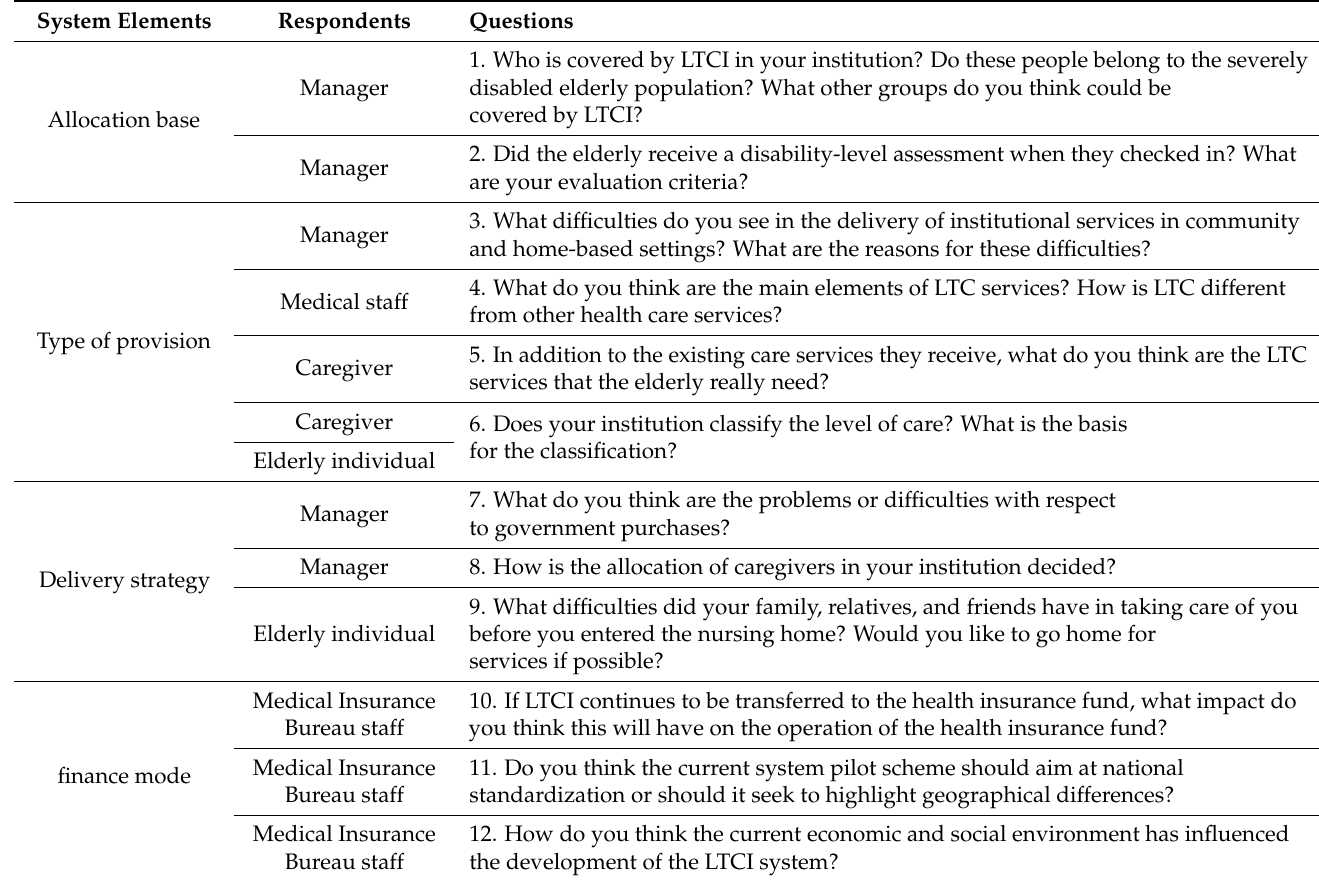
Table 2. Semi-structured interview